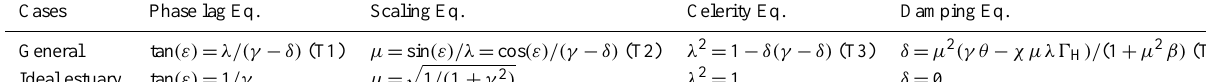
Table 2. Analytical solutions for tidal dynamics accounting for river discharge (Cai et al., 2014). Cases